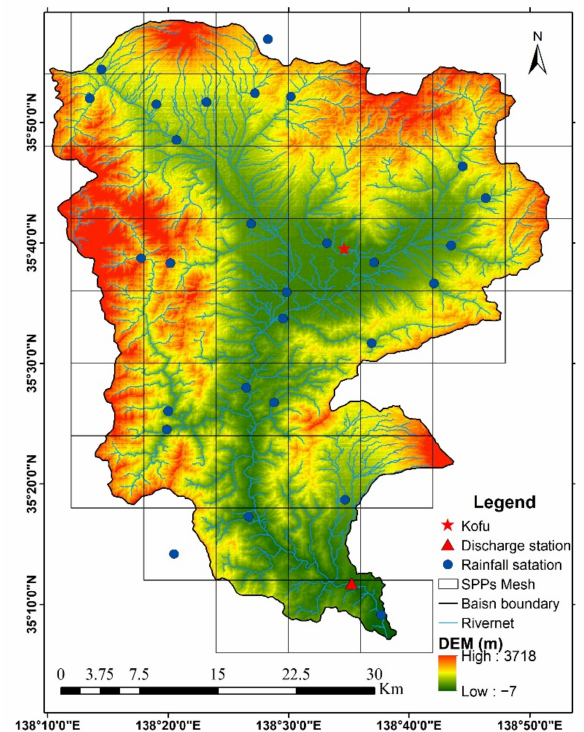
Figure 1. Digital Elevation Model (DEM) and gauge stations in the Fuji River basin. In total, twenty- eight rain gauges and forty-seven SPP meshes were involved in the calculation. The capital of Yamanashi Prefecture, Kofu city, is located in the Kofu